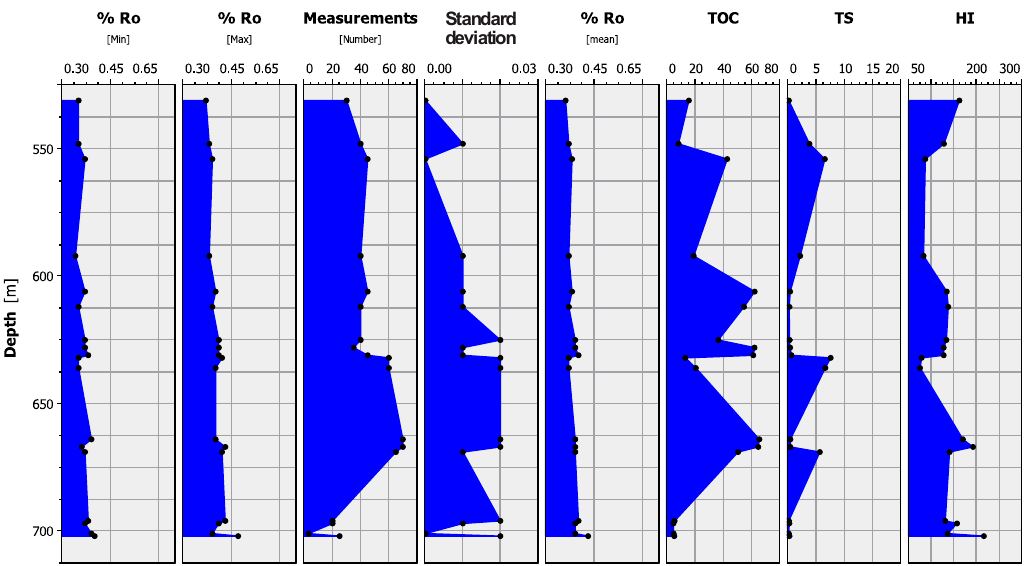
Figure 6. Graphic distribution of vitrinite reflectance analysis (%Ro), total organic carbon (TOC), total sulfur (TS), and hydrogen index (HI) of the Cerrejón Formation in the ANH-CARRETALITO-1 Well, see Supplementary Materials Table S3.